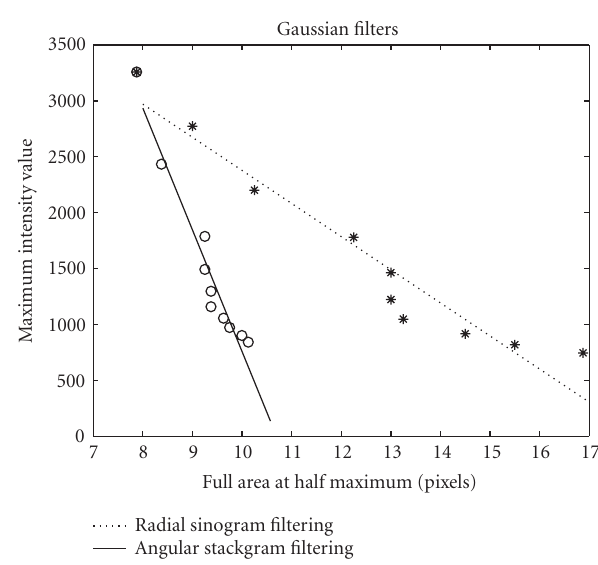
Figure 6: Maximum-intensity-value versus FAHM for the com- pared methods with the Gaussian lowpass filters. Polynomials of the first degree were fitted for the shown data points, which rep- resent the 10 filter kernels. The cut-o ff frequency of the filters de- creases from top-left to bottom-right. As can be seen angular stack- gram filtering preserves the resolution (or FAHM) better than radial sinogram filtering, although the maximum-intensity-values or the maximum-counts decrease almost